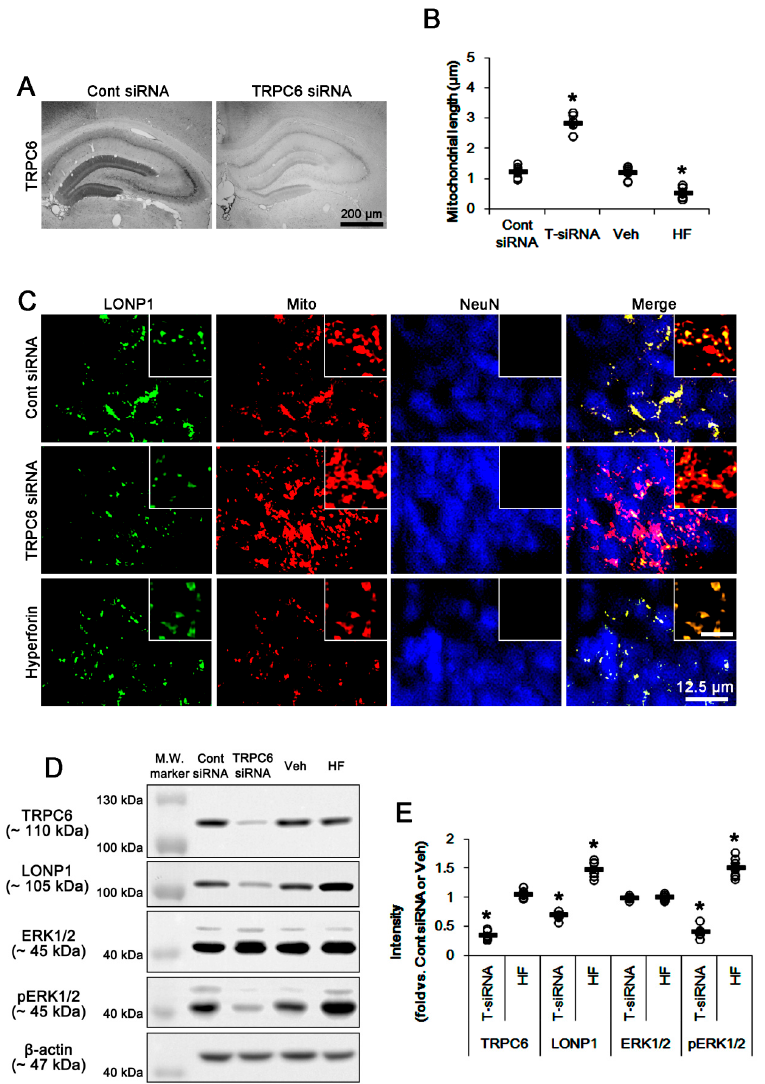
Figure 1. Effects of TRPC6 siRNA and hyperforin on mitochondrial dynamics, LONP1 expression, and ERK1/2 phosphorylation under certain physiological conditions . ( A ) Representative images of control- and TRPC6 siRNA-treated animals. TRPC6 expression is predominantly detected in the molecular layer of the dentate gyrus and DGC. TRPC6 siRNA effectively decreases TRPC6 expression. ( B , C ) Effects of TRPC6 siRNA and hyperforin on mitochondrial length. TRPC6 siRNA (T-siRNA) leads to mitochondrial elongation, while hyperforin (HF) facilitates mitochondrial fragmentation. ( B ) Quantification of mitochondrial length. Open circles indicate each individual value. Horizontal bars indicate mean value (mean ± S.E.M.; * p < 0.05 vs. control siRNA and vehicle, respectively; Student t -test; n = 7, respectively). ( C ) Representative double immunofluorescent images for LONP1 and mitochondria (Mito). Inserts are high magnification images (insert bar = 1.25 μ m). ( D , E ) Effects of TRPC6 siRNA and hyperforin on expressions of TRPC6 and LONP1, and ERK1/2 phosphorylation. TRPC6 siRNA (T-siRNA) decreases protein levels of TRPC6 and LONP1, and ERK1/2 phosphorylation. Hyperforin (HF) increases LONP1 expression and ERK1/2 phosphorylation without changing TRPC6 expression. ( D ) Representative western blots of expressions of TRPC6 and LONP1, and ERK1/2 phosphorylation (M.W. marker, Molecular weight marker). ( E ) Quantification of expressions of TRPC6 and LONP1, and ERK1/2 phosphorylation based on western blot data. Open circles indicate each individual value. Horizontal bars indicate mean value (mean ± S.E.M.; * p < 0.05 vs. control siRNA and vehicle, respectively; Student t -test; n = 7, respectively).